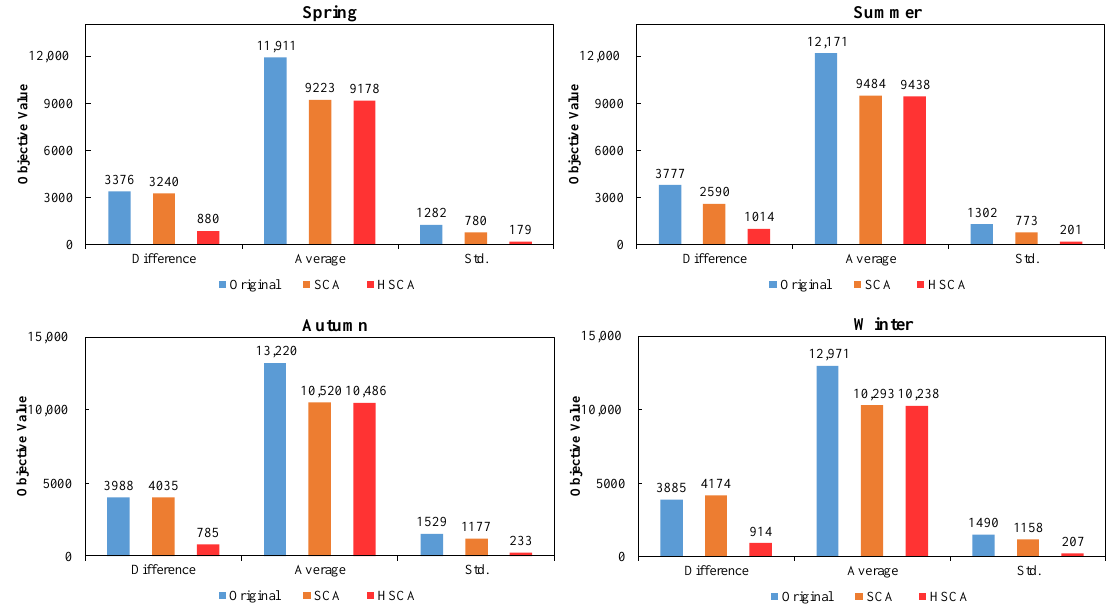
Figure 14. Statistical indexes of the original load and the residual loads obtained by Sine Cosine Algorithm (SCA)and HSCA.